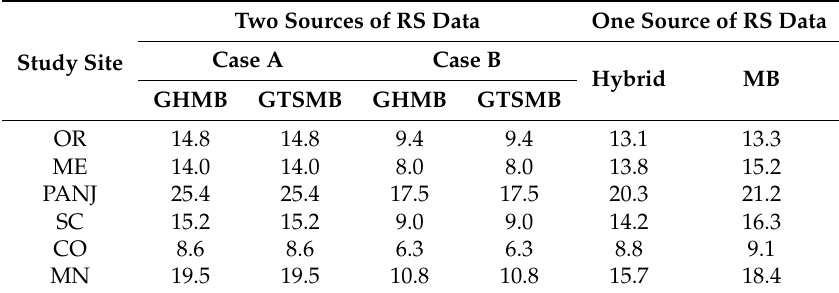
Figure 4. The average relative standard error for the different methods, [%]. Table 8. Relative standard error in the study sites, (cid:100) rSE ,